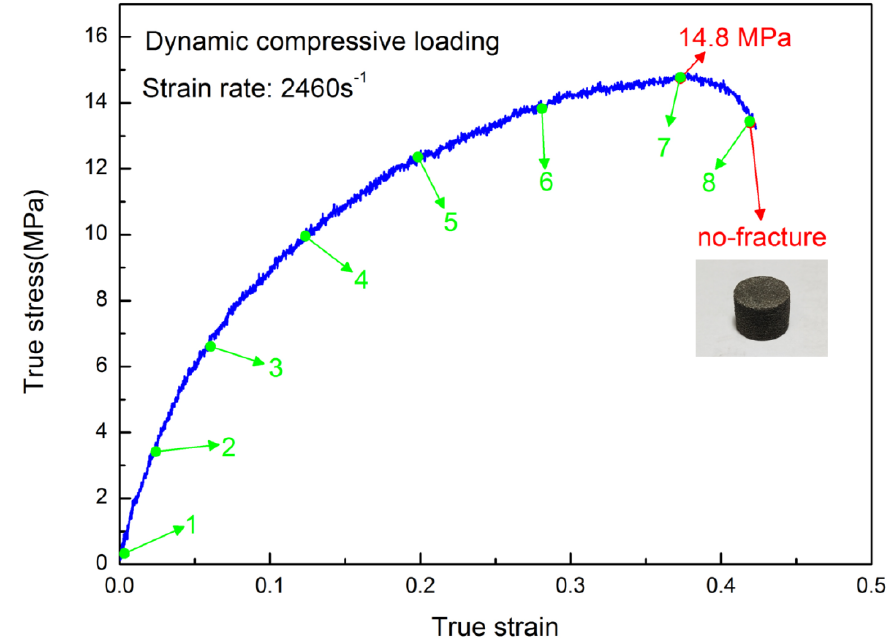
Figure 4. True stress–strain curve of H-80W under the strain rate of 2460 s −1 without causing an ultimate fracture. The green numbers in the curve correspond to the numbers marked in the images recorded by a high-speed digital camera in Figure 5.